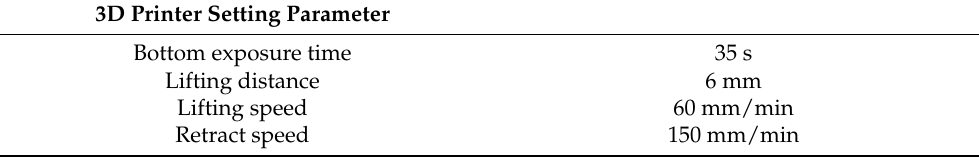
Table 2. Detailed setting for printing the structure with 8k grey resin by Mini 4K Phrozen printer.